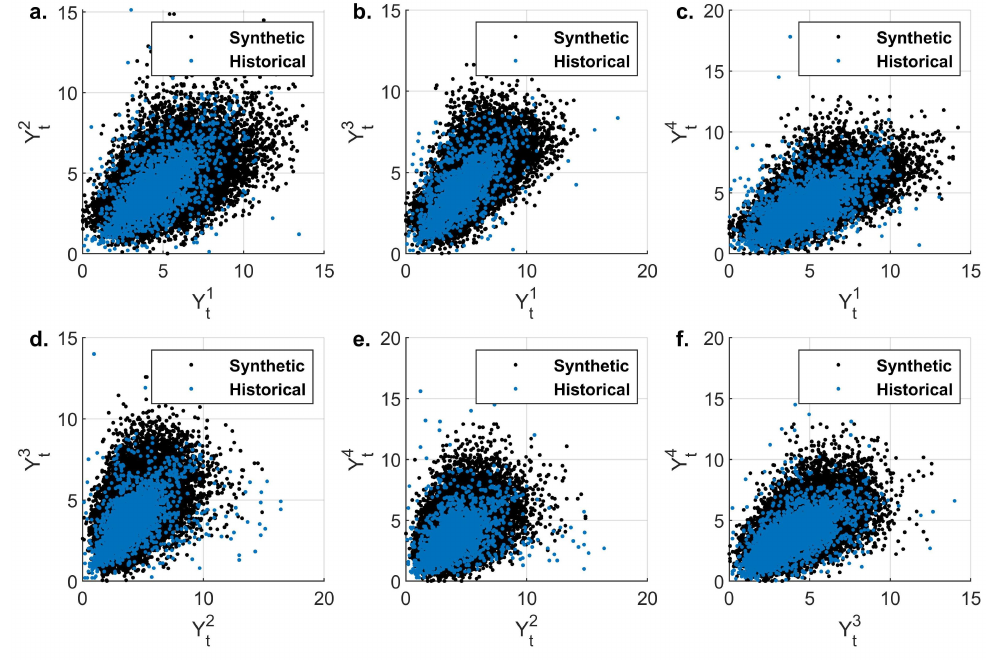
Figure 11. Scatter plot of historical and synthetic cross-dependence structure. ( a ) Atenco–La Grande { Y 1 } , ( b ) Atenco–San Andres { Y 1 , Y 2 t t } , ( e ) La Grande–Chapingo (DGE) { Y 2 San Andres { Y 2 , Y 3 t t } . (DGE) { Y 3 , Y 4 t t